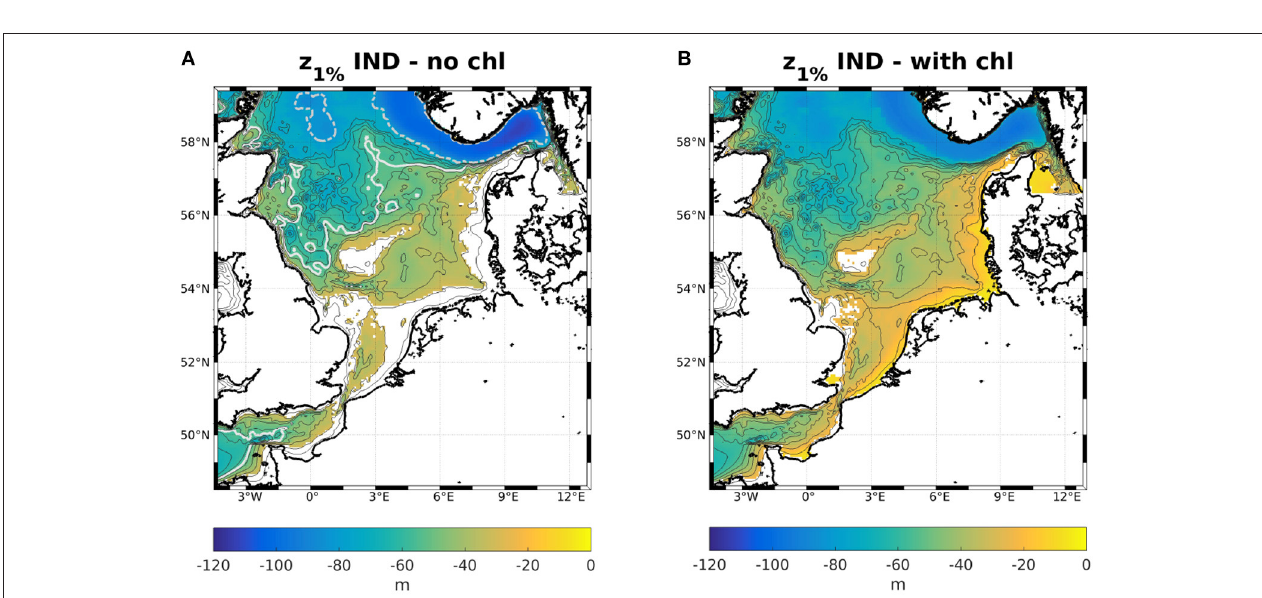
FIGURE 2 | Colors: 1 % -depths for the IND scheme (A) neglecting chlorophyll and (B) considering chlorophyll. The dashed gray isoline in (A) is the 1 % -, and the white isoline is the 10 % -depth of the classic scheme. Blank cells mark areas where the bottom layer irradiance is higher than 1 or 10 % , respectively.